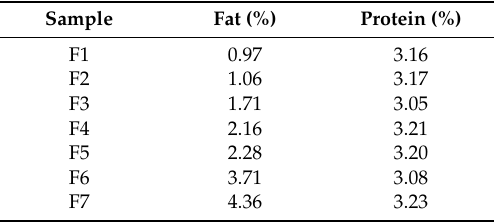
Table 1. Milk samples used in the